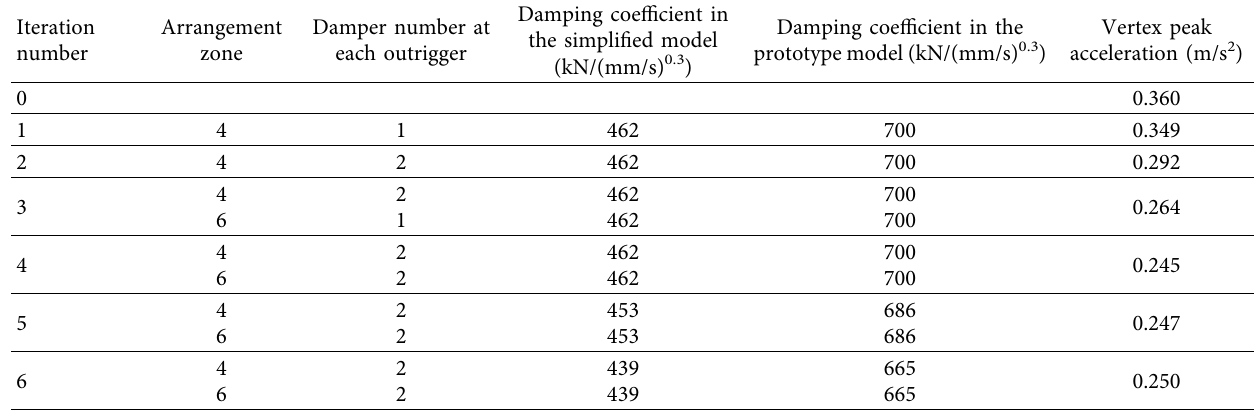
Table 14: Location, number, and damping coefficient during each step of the iteration (simplified model).